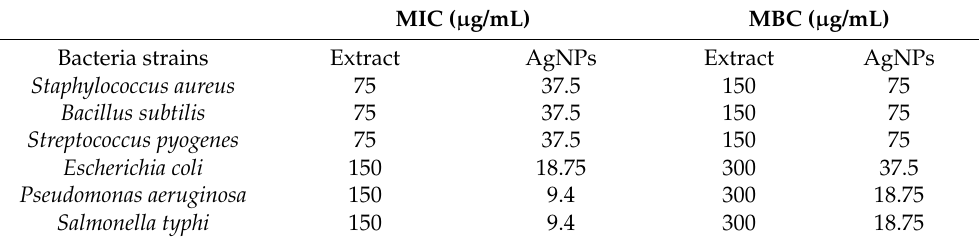
Table 2. The minimum inhibitory concentrations (MIC) and the minimum bactericidal concentrations (MBC) of the O. persica leaf extract and the phytofabricated AgNPs against Gram-positive and Gram-negative